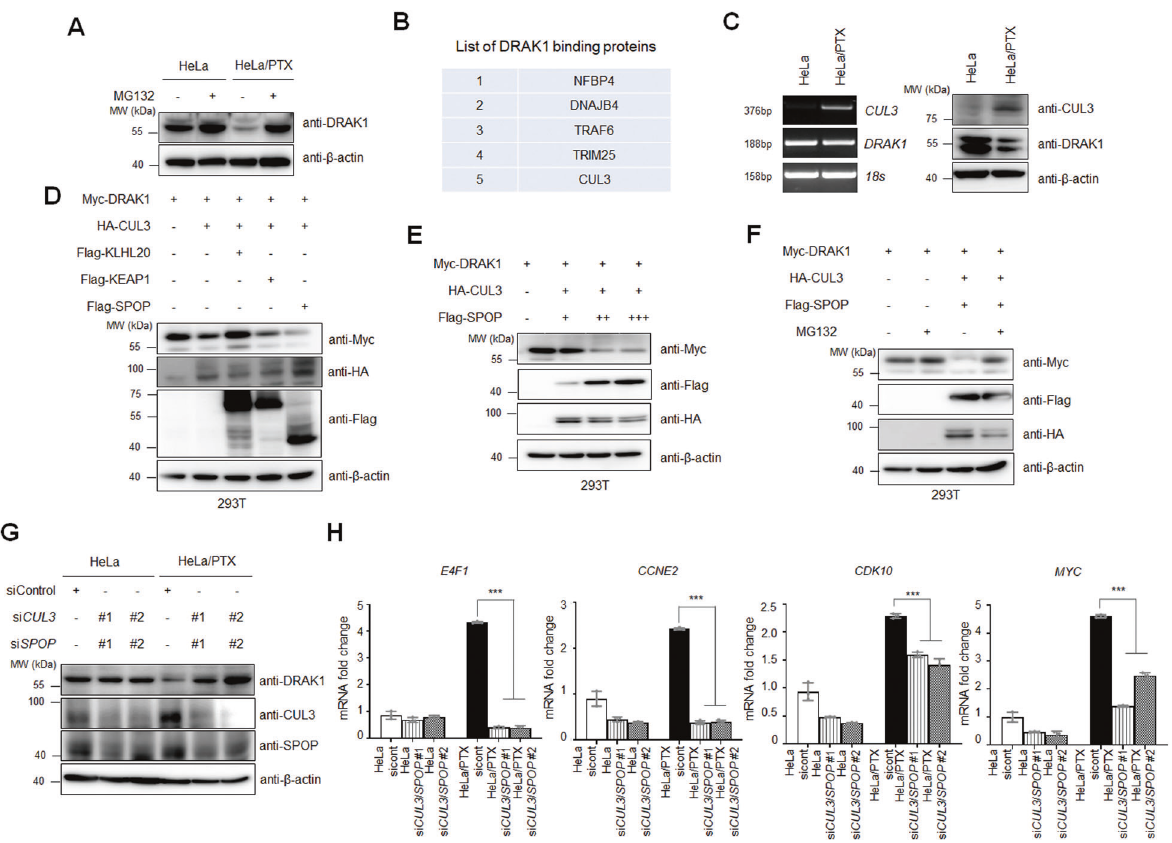
Fig. 5 DRAK1 protein is degraded by CUL3/SPOP E3 ubiquitin ligase in paclitaxel-resistant cells. A Immunoblot analysis showing DRAK1 expression in HeLa and HeLa/PTX cells with or without MG132 (10 μ M) treatment for 6 h and β -actin was used for internal control. B List of DRAK1 binding protein candidates analyzed from the mass spectrometry-based crosslinking assay. C RT-PCR (left) and immunoblot analysis (right) showing CUL3 and DRAK1 expression in HeLa and HeLa/PTX cells. 18 s or β -actin was used for internal control, respectively. D Immunoblot analysis showing Myc-DRAK1 expression by cotransfection of HA-CUL3 and its adaptor proteins, Flag-KLHL20, Flag-KEAP1, and Flag-SPOP in 293 T cells. E Immunoblot analysis showing the expression of Myc-DRAK1 by dose-dependent changes in the expression levels of Flag-SPOP with HA-CUL3. F Immunoblot analysis showing Myc-DRAK1 expression by cotransfection of HA-CUL3 and Flag-SPOP with or without MG132 (10 μ M) treatment for 4 h. G Immunoblot analysis showing endogenous DRAK1 expression in HeLa and HeLa/PTX cells transfected with CUL3 -siRNAs and SPOP -siRNAs. H qRT-PCR showing the expressions of downregulated target genes by DRAK1 overexpression validated from Fig. 4C in samples from G